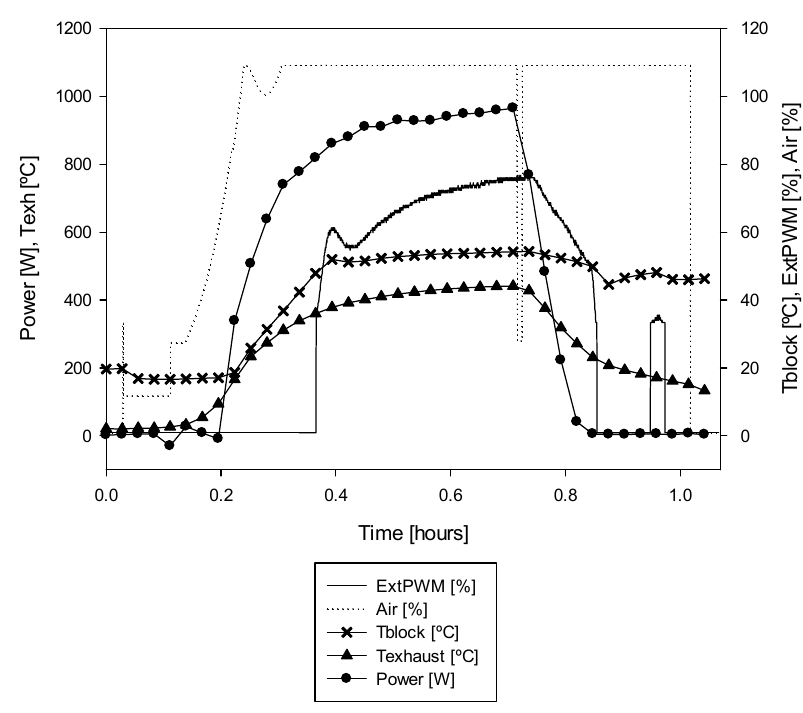
Figure 6. Obtained data from the